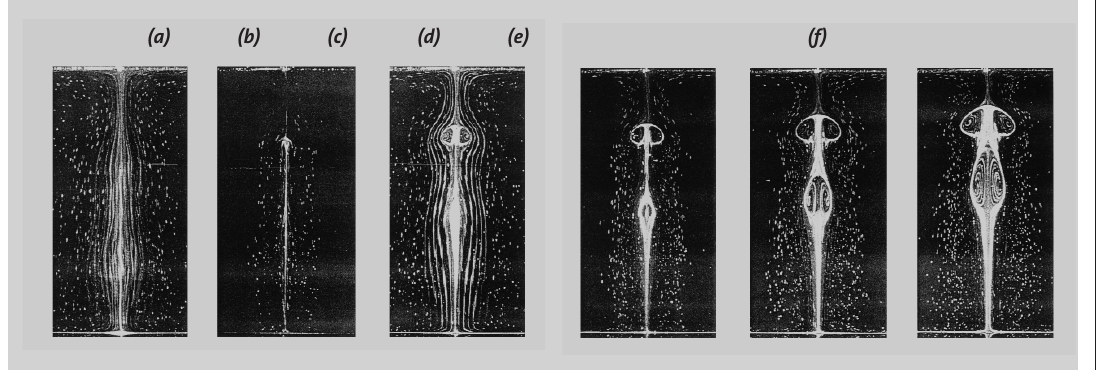
Figure 12: Flow visualisation images for the 45 ppm polyacry- lamide Boger fluid at H/R = 2.5 for (a) Re = 2015, We = 0.41; (b) Re = 2297, We = 0.47; (c) Re = 2373, We = 0.48; (d) Re = 2443, We =0.5; (e) Re = 2636, We = 0.54; (f) Re = 2922, We =